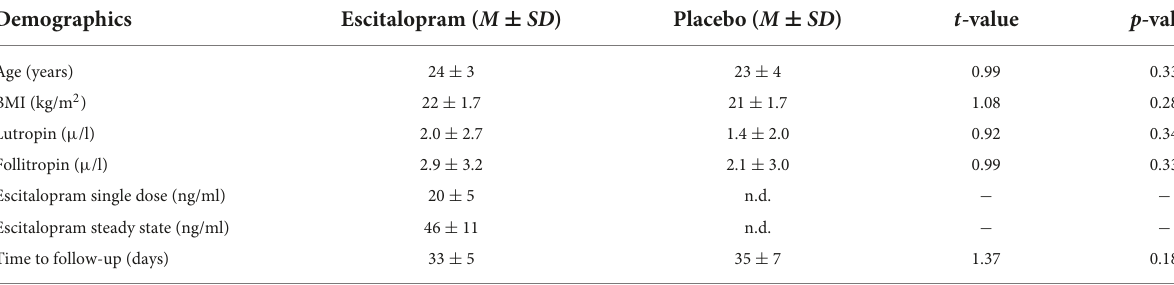
TABLE 1 Demographic analysis overview: Baseline and demographic variables across both